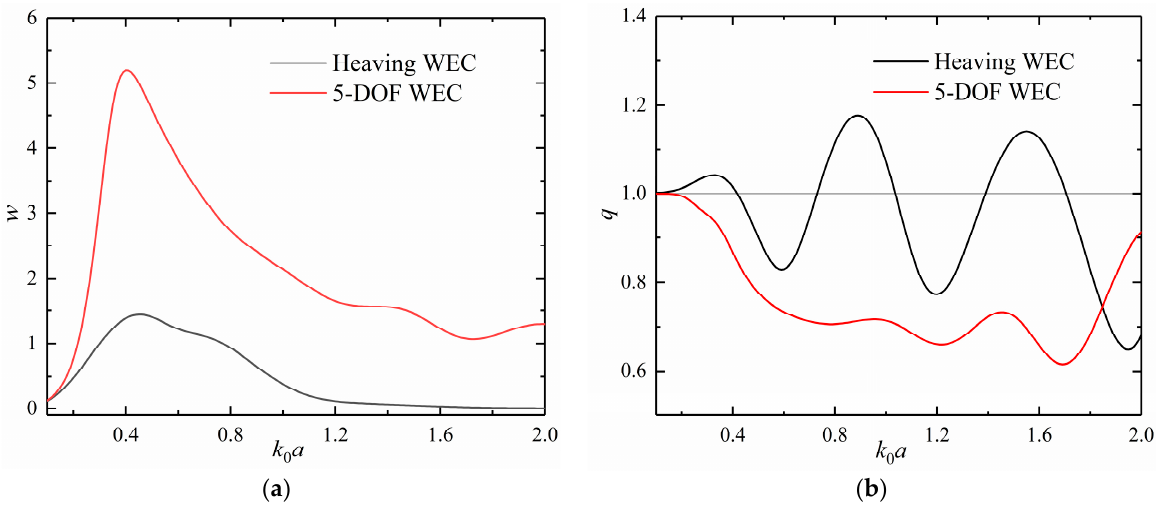
Figure 7. The performance of an array composed of two WECs parallel to the incident wave: ( a ) capture width; ( b ) interaction factor. Heaving WEC: each WEC moves and extracts power in heave mode only; 5 ‐ DOF WEC: each WEC moves and extracts power in five degrees of freedom.